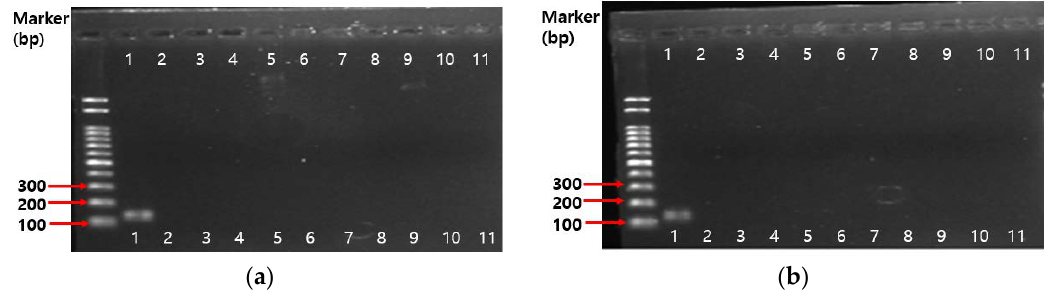
Figure 3. PCR analysis results of the antibiotic resistance gene in B. bifidum BGN4 and B. longum BORI: ( a ) B. bifidum BGN4; ( b ) B. longum BORI; Lane 1: Bifidobacterium genus-specific primers; Lane 2: gentamicin( aaac(6)-aph(2) ), Lane 3: kanamycin( AphA3 ), Lane 4: streptomycin( aadE ), Lane 5: trimethoprim( dfrA ); Lane 6: tetracycline K( tet (K)); Lane 7: tetracycline L( tet (L)); Line 8: tetracycline M( tet (M)), Lane 9: tetracycline O( tet (O)), Lane 10: tetracycline S( tet (S)); Lane 11: kanamycin( aaaD ).